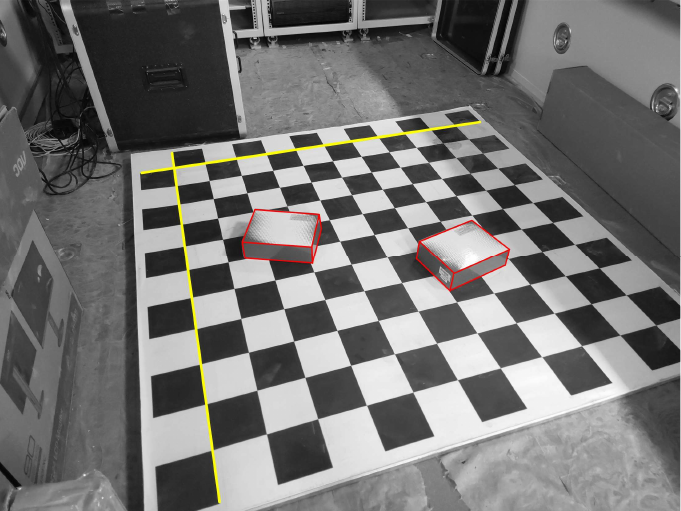
Figure 9. The projections (Red) of the known lines using the estimated pose with two 3D lines (Yellow). The projection is affected by the pose estimation, and, hence, the error between the projection and the corresponding line segment on the real images can intuitively reflect the error of pose estimation. From Figure 9, it can be seen that the error between the pro- jection and the corresponding line segment on the real images is low, which shows, from another perspective, that our proposed method has good performance in real scenarios. 4. Discussion In this paper, we propose a fast and accurate method to estimate the focal length and pose using two 2D–3D line correspondences and the camera position. Our core contribu- tion is to convert the PnL problem with 2D–3D line correspondences into the estimation problem with 3D – 3D point correspondences. To the best of our knowledge, this is the first study to use the camera position and line correspondences simultaneously to estimate the focal length and pose. Using the camera position as the prior knowledge, two planes can be obtained in the camera frame and world frame, respectively. Then, two angles between the two planes in the camera frame and world frame, respectively, can be obtained. Since there is only a rigid body transformation, the angle remains the same in either frame. Hence, the two angles are equal, and, using this information, we can estimate the focal length efficiently and independently. When we estimate the camera pose, another geometric characteristic is used, where we establish the transform between the unit normal vectors of the two planes with this characteristic, and this transform can be regarded as the camera projection of the 3D point. Then, the pose estimation using line correspondences is converted into pose estimation using 3D – 3D point correspondences in intermediate frames, and the latter pose estimation can be finished quickly using traditional point-based solvers. The differences and ad- vantages of our proposed method are discussed as follows.